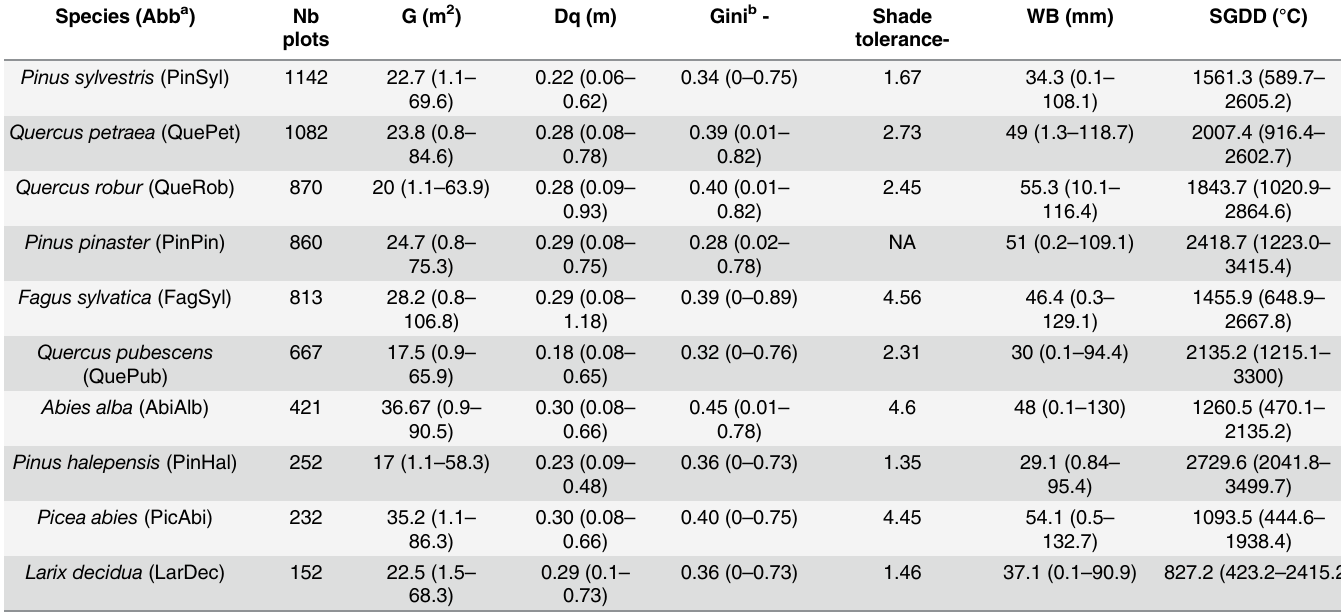
Table 1. Characteristics of the plots for the ten species studied.